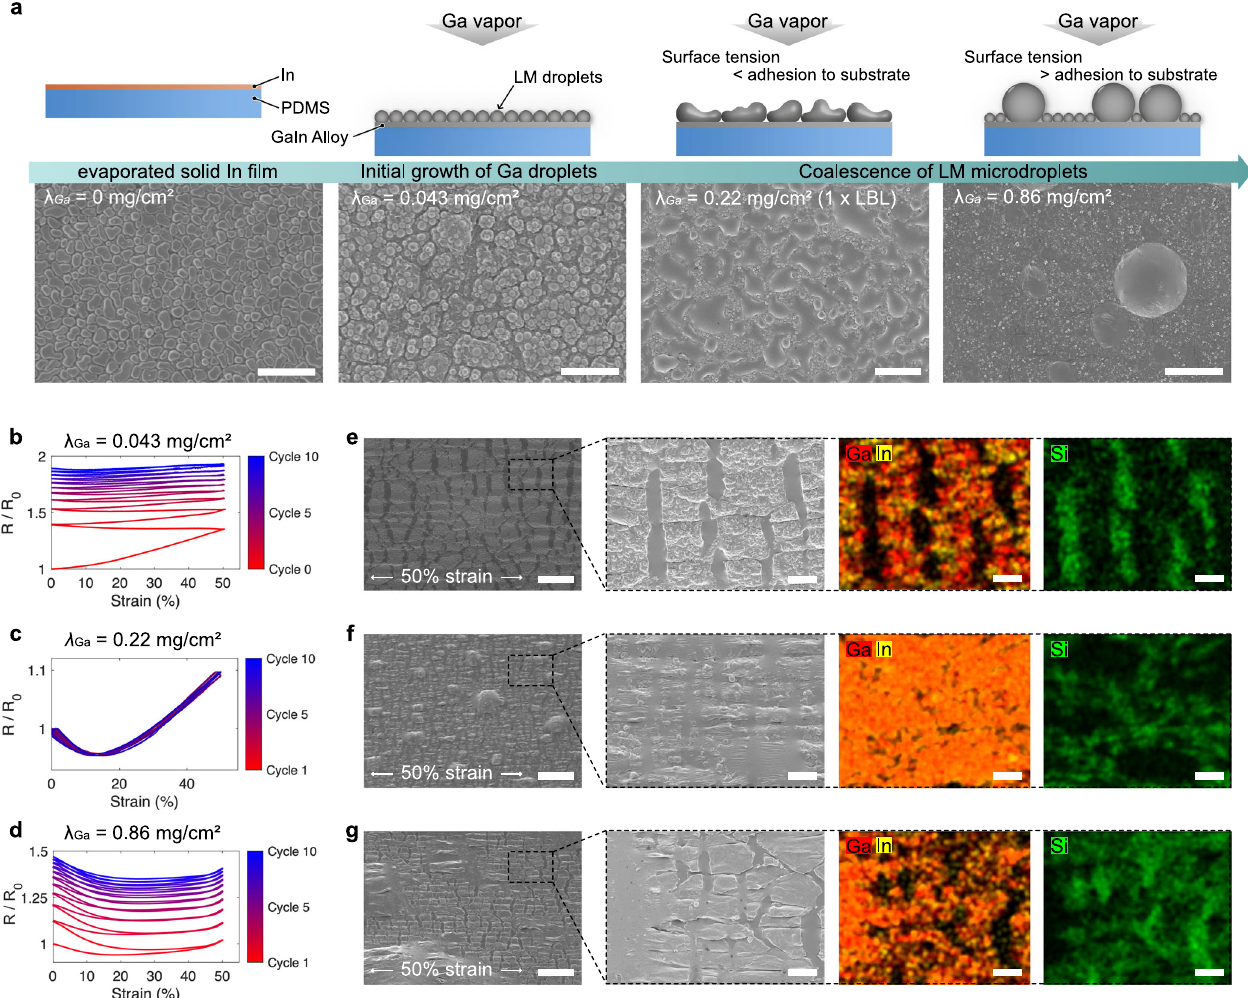
Fig. 2 Characterization of LM microstructures with a single gallium layer. a Evolution of an LM microstructure as the evaporated mass of gallium increases. Schematic illustrations and SEM images are presented for deposited gallium mass per unit area: λ Ga = 0 mg cm − 2 , = 0.043 mg cm − 2 , λ = 0.22 mg cm − 2 , and λ = 0.86 mg cm − 2 from left to right (scale bars: 2, 2, 5, and 20 µm from left to right). An indium λ Ga Ga Ga layer with a thickness of 150 nm was deposited onto a PDMS substrate prior to the gallium evaporation. A uniform, entire coverage of gallium on the fi lm is achieved only with λ Ga = 0.22 mg cm − 2 (1 × LBL). b – d Relative resistance responses of the LM microstructures of = 0.043 mg cm − 2 ( b ), λ = 0.22 mg cm − 2 ( c ), λ = 0.86 mg cm − 2 ( d ). Resistance values were measured during ten cycles of 50% tensile λ Ga Ga Ga strain with the samples pre-strained up to 50% before the measurement. e – g SEM images and energy dispersive spectroscopy (EDS) mappings of the LM microstructures of λ Ga = 0.043 mg cm − 2 ( e ), λ Ga = 0.22 mg cm − 2 ( f ), λ Ga = 0.86 mg cm − 2 ( g ) under 50% tensile strain; gallium (red) and indium (yellow) are the evaporated metals; silicon (green) represents the underlying PDMS substrate (scale bars: 10 µm; inset image scale bars: 2